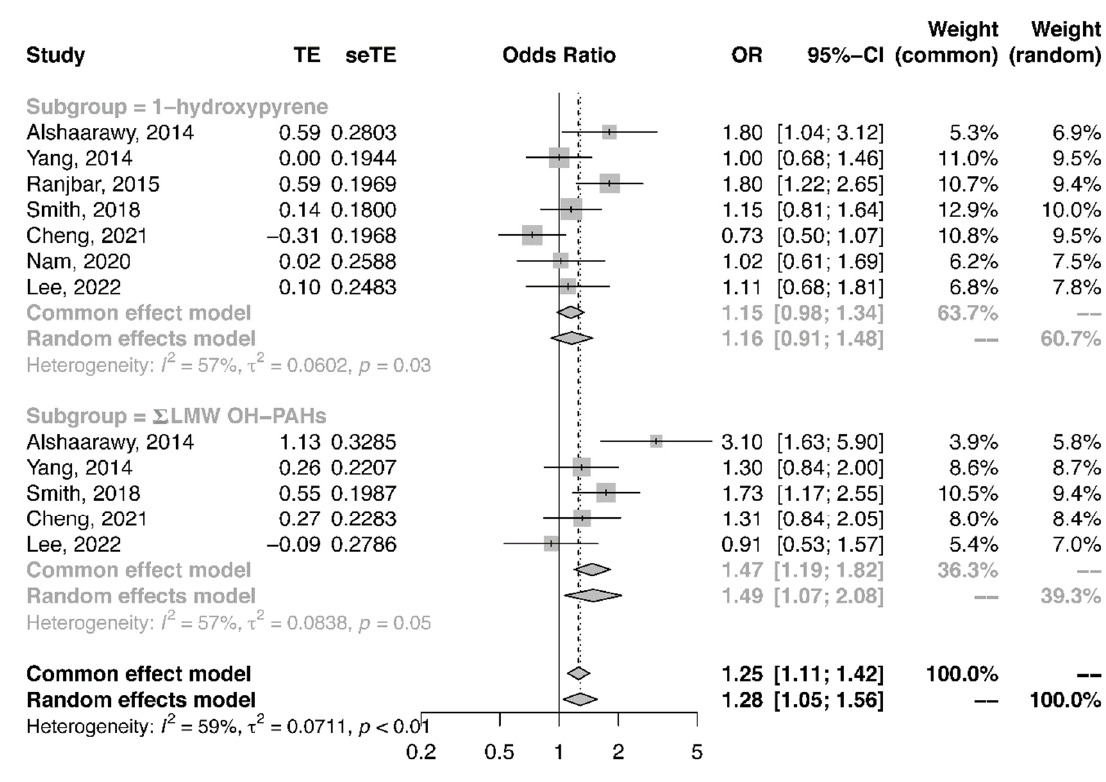
Figure Figure 5. The association between urinary 1-OHP, Σ OH-PAH metabolites, and risk of T2DM [20– 25,28].